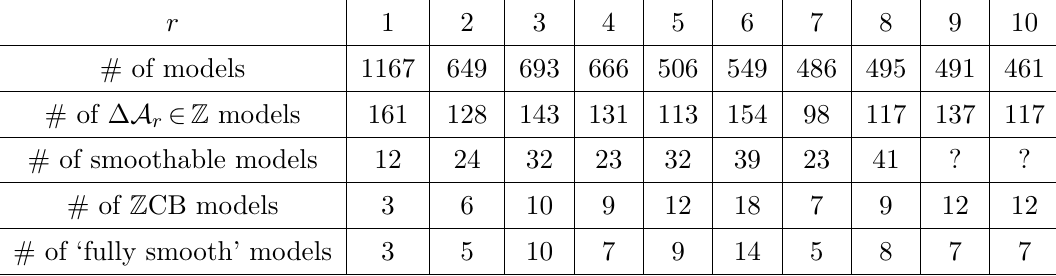
Table 4 . Number of low-rank models in our dataset. Here, Z CB refers to the models with integral CB dimensions and ‘fully smooth’ refers to the smoothable models with smooth exceptional